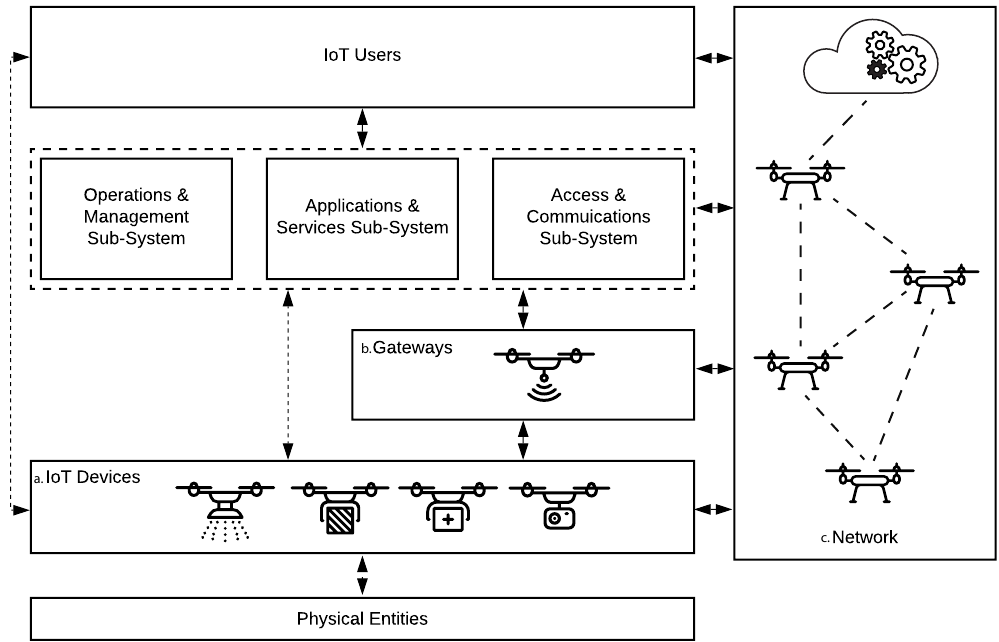
Figure 1. Role of unmanned aerial vehicle (UAV) within Internet of Things (IoT) as: ( a ) smart terminal devices that interact with the physical world; ( b ) aerial base stations and gateways; ( c ) communication network connected to IoT